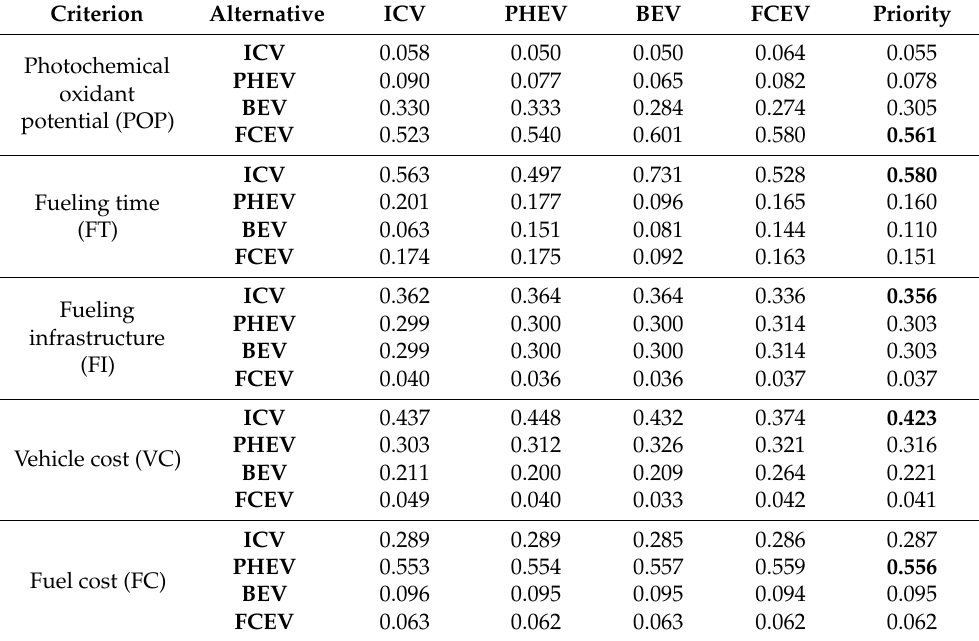
Table 8. Standard matrix of importance ratios between alternatives for the POP, FT, FI, VC, and FC criteria.